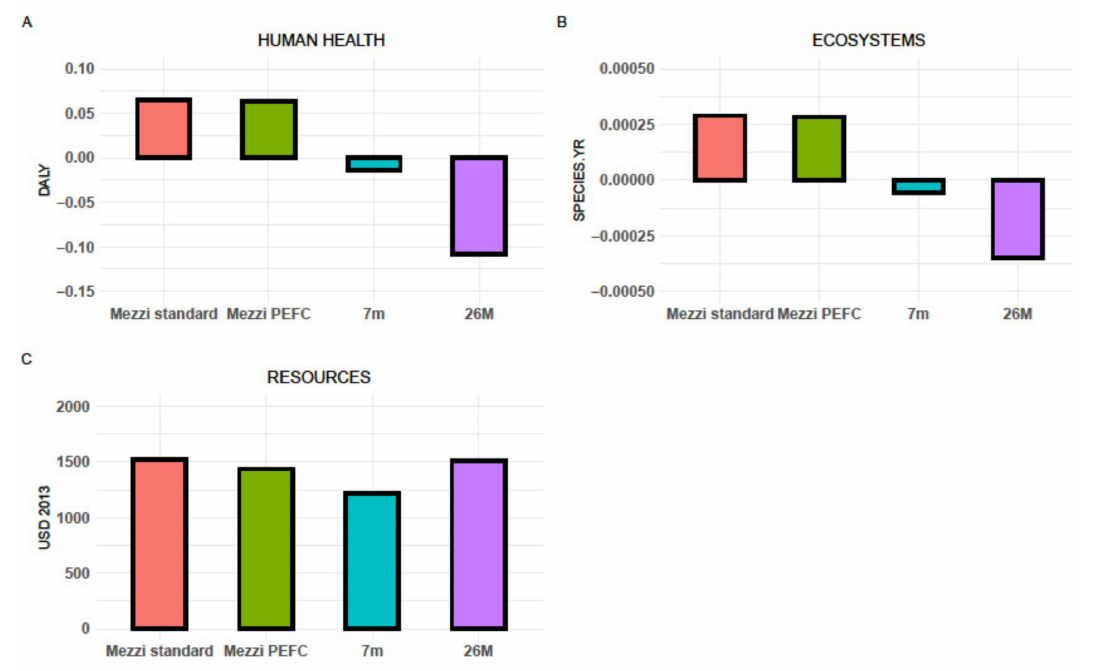
Figure 3. ( A ) Measurement of the effects on human health expressed in years lived, with a worse quality of life in a 10-year rotation. ( B ) Effects on ecosystems expressed in the number of extinct species per year in a 10-year rotation. ( C ) Resource consumption in USD2013 (monetary cost) over a 10-year